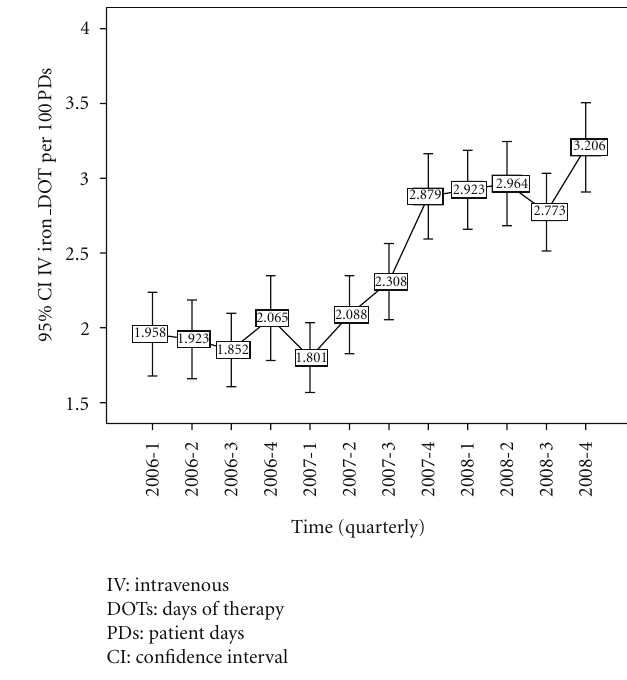
Figure 3: Mean IV Iron DOTs/100 PDs use (with 95% CI) from 2006–2008 (by each